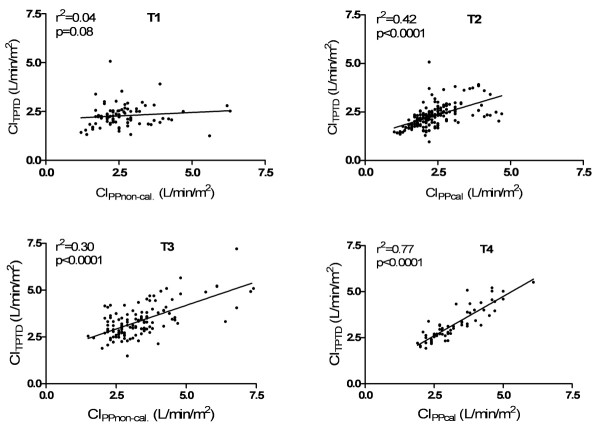
Correlation of cardiac indices before (T1, T2) and after (T3, T4) cardiopulmonary bypass.